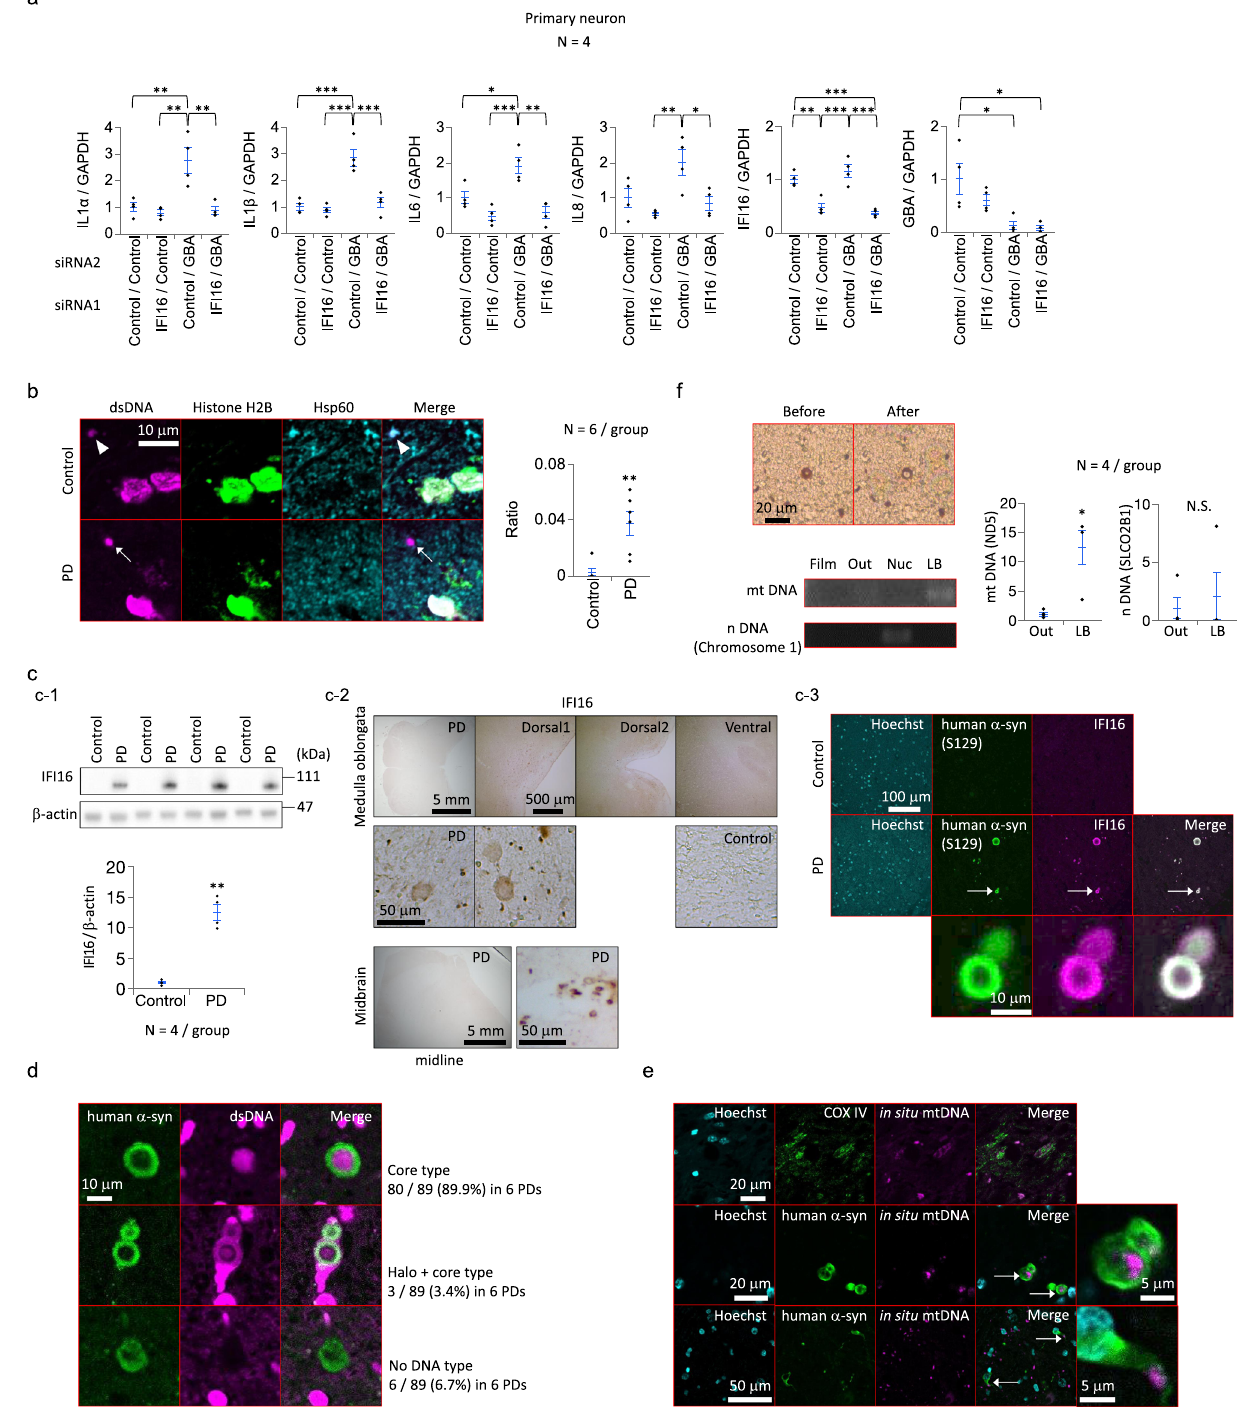
crossed to obtain homozygous mutant (gba KO or DNase II KO) and control fi sh. The oligos used for PCR and sequencing are listed in Supplementary Table 3. Plasmid DNA ( Xenopus neural-speci fi c beta-tubulin (NBT) promoter: human DNase II- fl ag IRES GFP) was microinjected into the soma of one-cell stage wild- type embryos ( = P0 generation, mosaic) at a concentration of 25 ng/ml to generate human DNase II transgenic fi sh. For the generation of stable transgenic fi sh, transgene cassettes fl anked by recognition sites for the Tol2 transposase were used, and the DNA was supplemented with 25 ng/ml mRNA encoding the Tol2 transposase to increase the genomic integration of the transgene cassette 40 . The injected P0 generation was raised to adulthood and crossed with wild-type fi sh to screen embryos of the F1 generation for the inherited expression of the fl